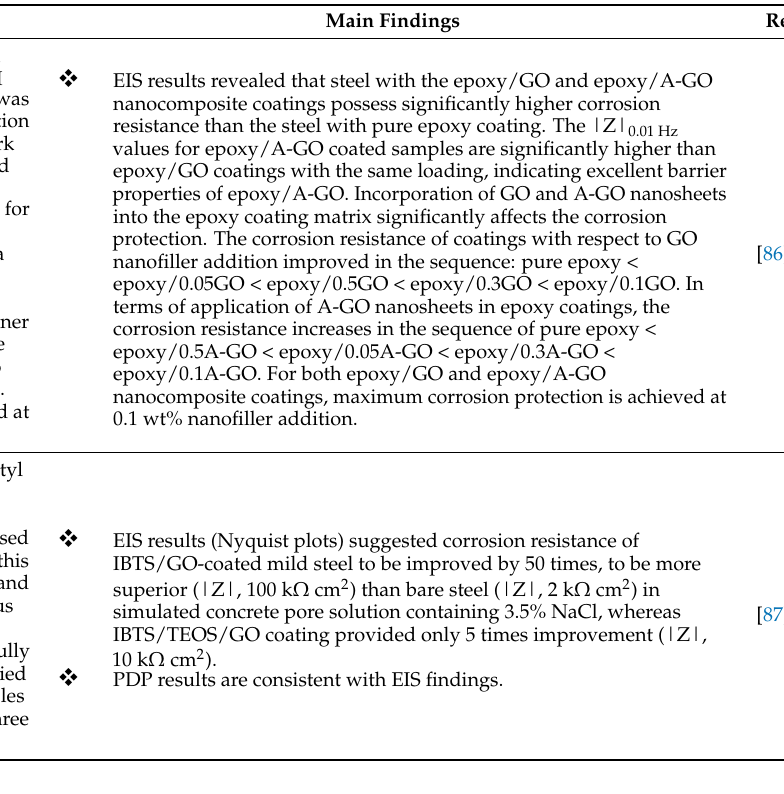
Table 1. Cont . Table 1. Different approaches for improving silane coatings and the main findings, as reported in the literature. Coating Preparation Main Findings Ref. Coating Preparation Main Findings Ref.